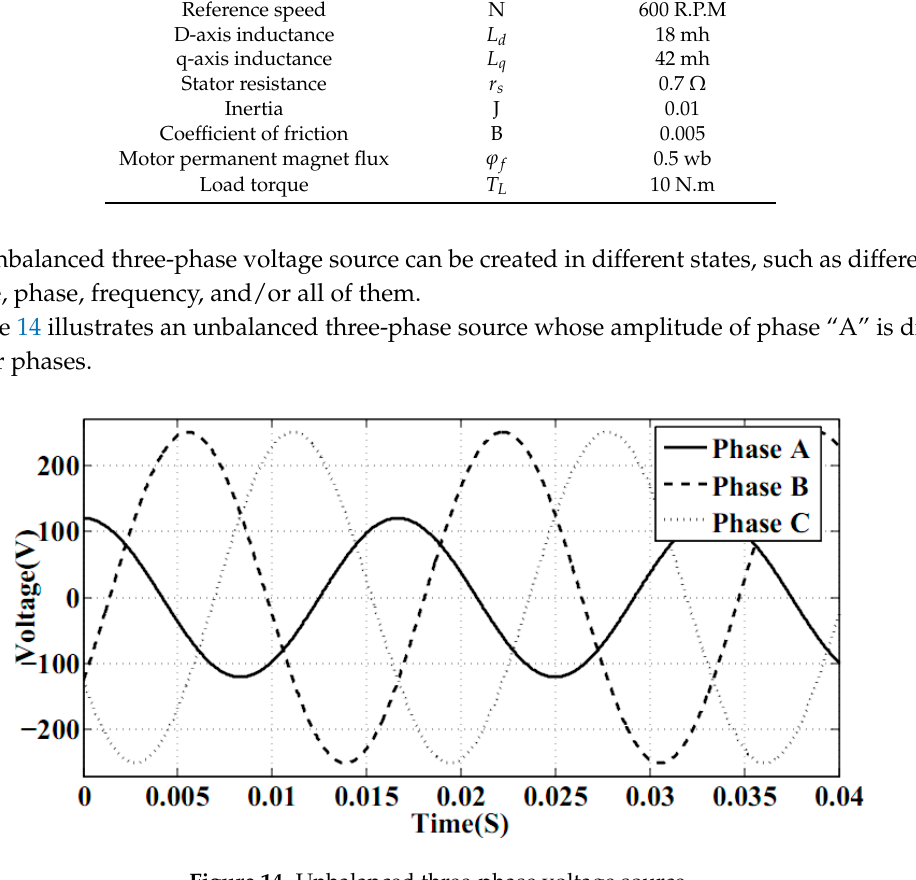
( c ) Figure 15. Characteristics of the motor compared with the reference. ( a ) Speed of the motor; ( b ) Electromagnetic torque; ( c ) stator flux in the α axis of the stationary frame. As shown in Figure 15a, the motor speed will follow its reference value properly. The reference speed value is 600 R.P.M. and the results are shown in Table 2.